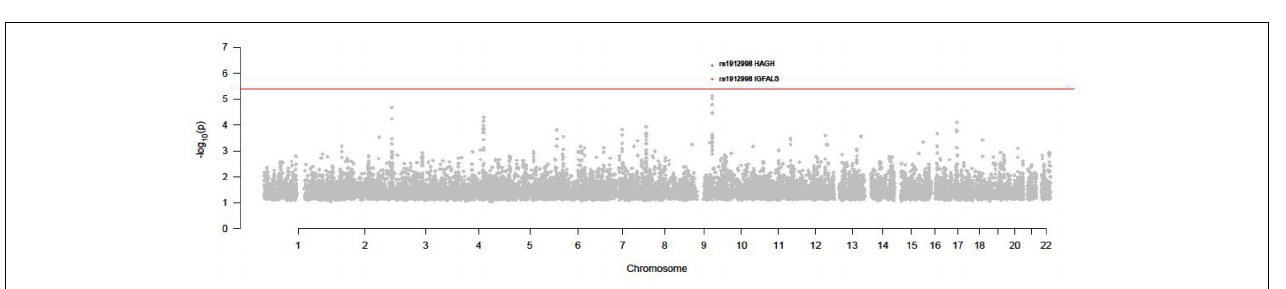
FIGURE 5 | P value of all SNPs in SMR test (GWAS and thyroid